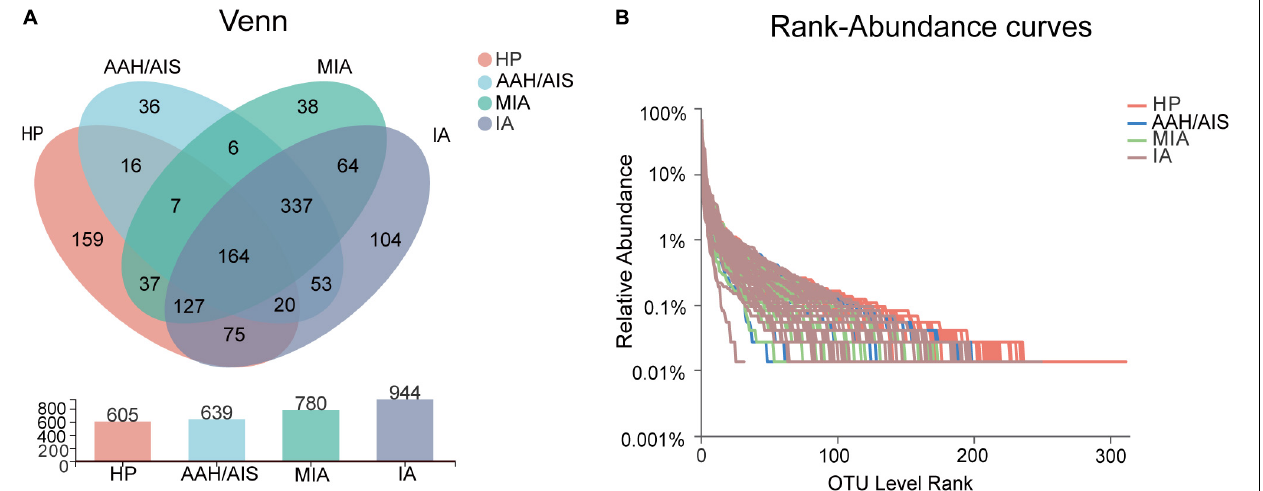
diagram. Therefore, samples with high similarity in community structure tend to cluster together, while those with very different communities are far apart. We performed the PCA analysis between the four groups as shown in Figure 3A . When PC1